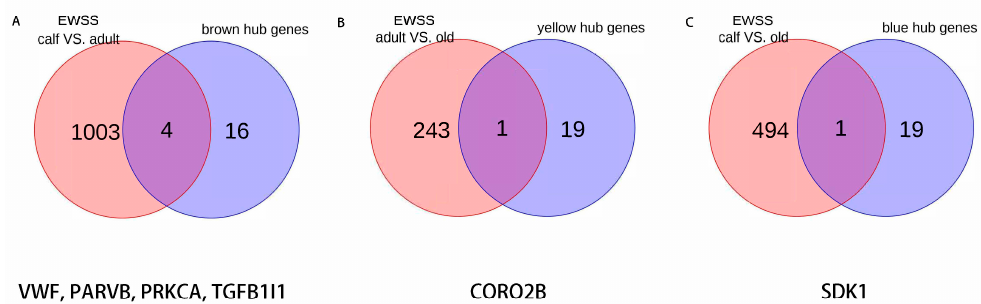
Figure 6. ( A ) Manhattan plots of SNPs in calf compared with adult. ( B ) Manhattan plots of SNPs in adult compared with old. ( C ) Manhattan plots of SNPs in calf compared with old.